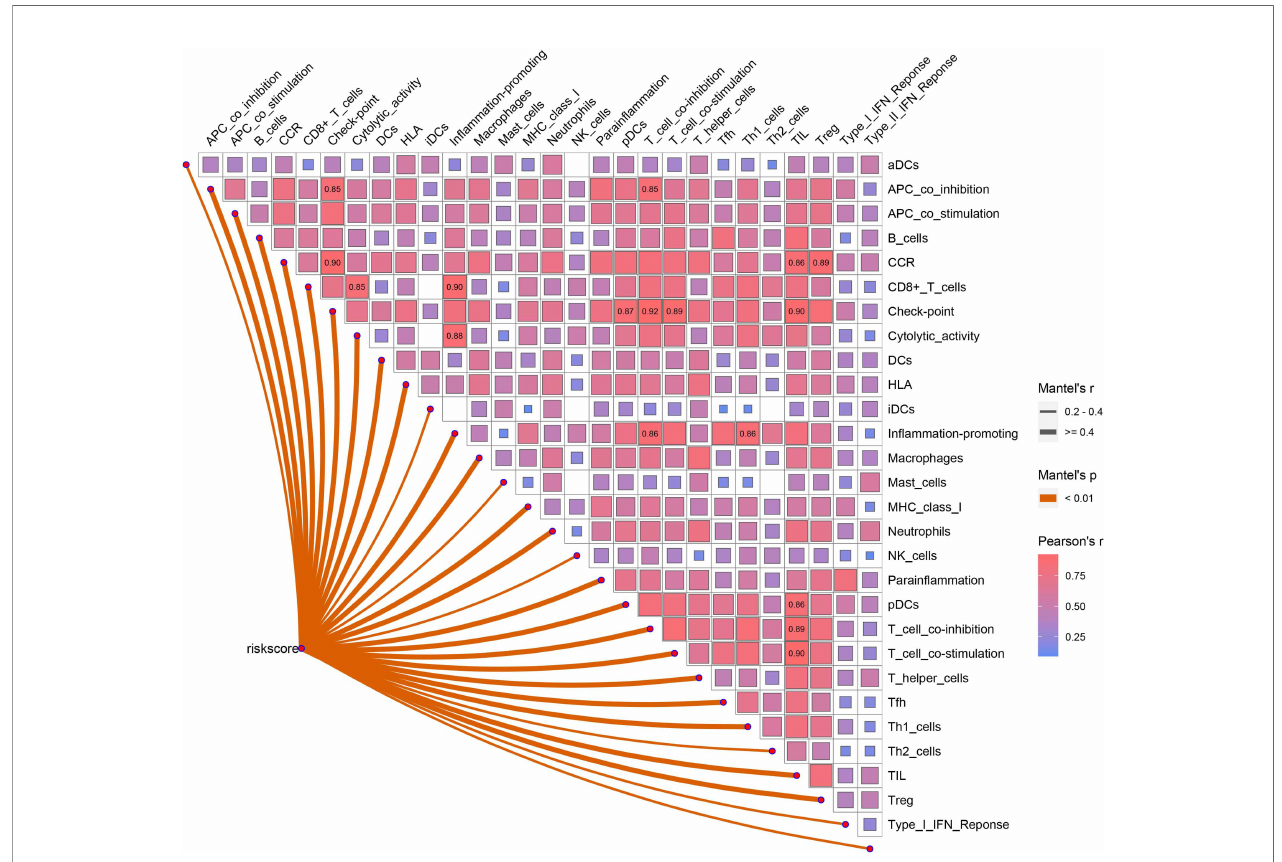
FIGURE 9 | Correlation between HAGS and immune cells in fi ltration. The correlation between risk score and speci fi c immune cells is shown with solid lines; the line color is related to the p -value. The square colors represent Pearson correlation coef fi cients between different immune cells; only the Pearson r ≥ 0.85 is